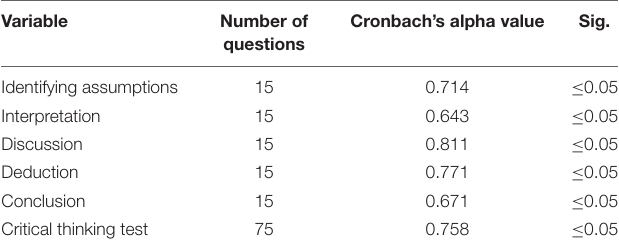
TABLE 2 | “Cronbach’s alpha coefficients” for sub-tests and the whole critical thinking test.